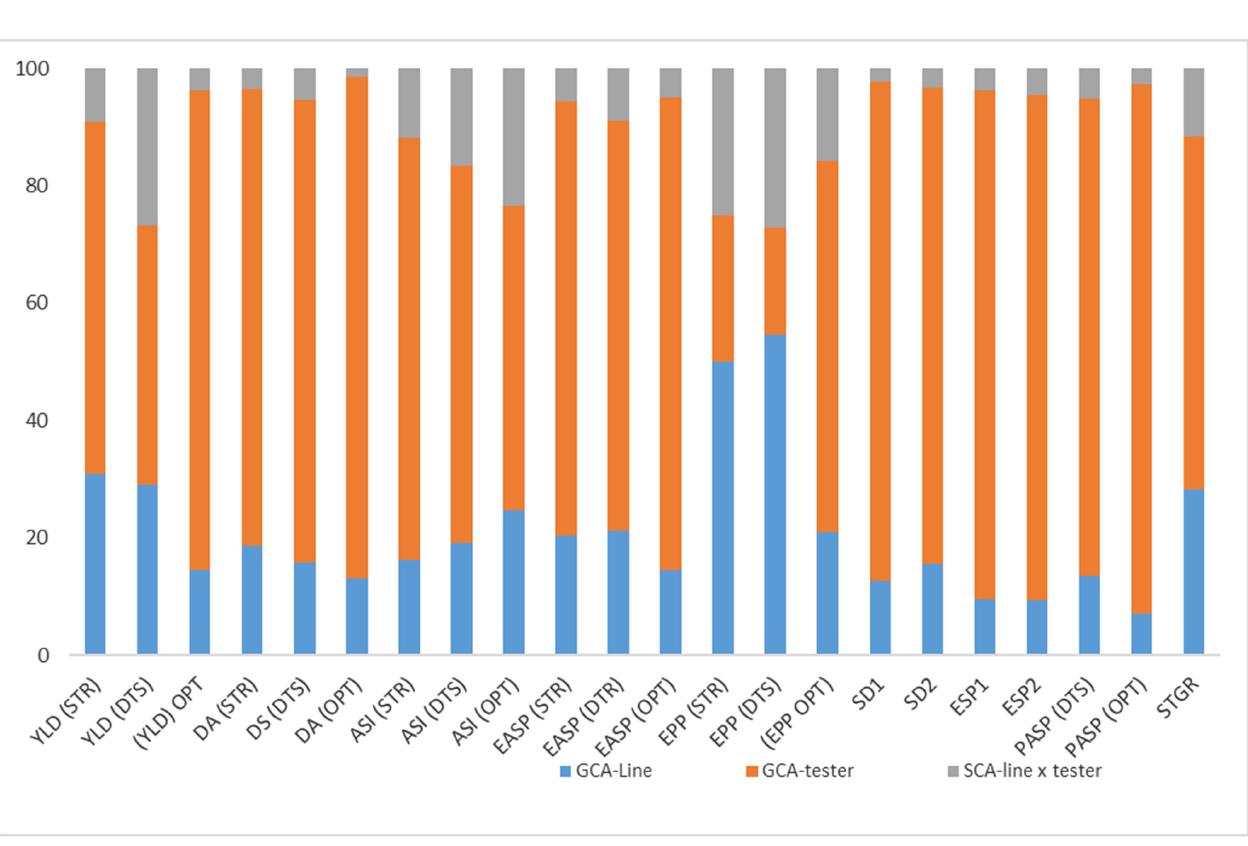
Figure 1. The proportion of total genotypic sum of squares attributable to GCA (line) (lower bar), GCA (tester) (middle bar), and SCA (line × tester) (upper bar) for grain yield and other agronomic of extra-early provitamin A maize inbred lines and four testers. STR: Striga -infested, DTS: drought stress, OPT: optimum environment.